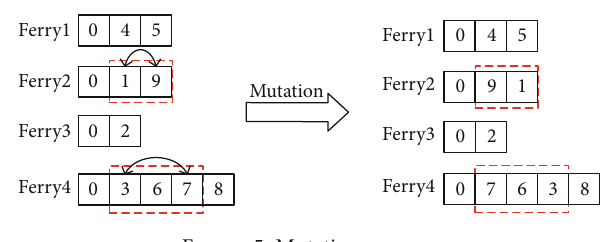
Figure 5: Mutation process.